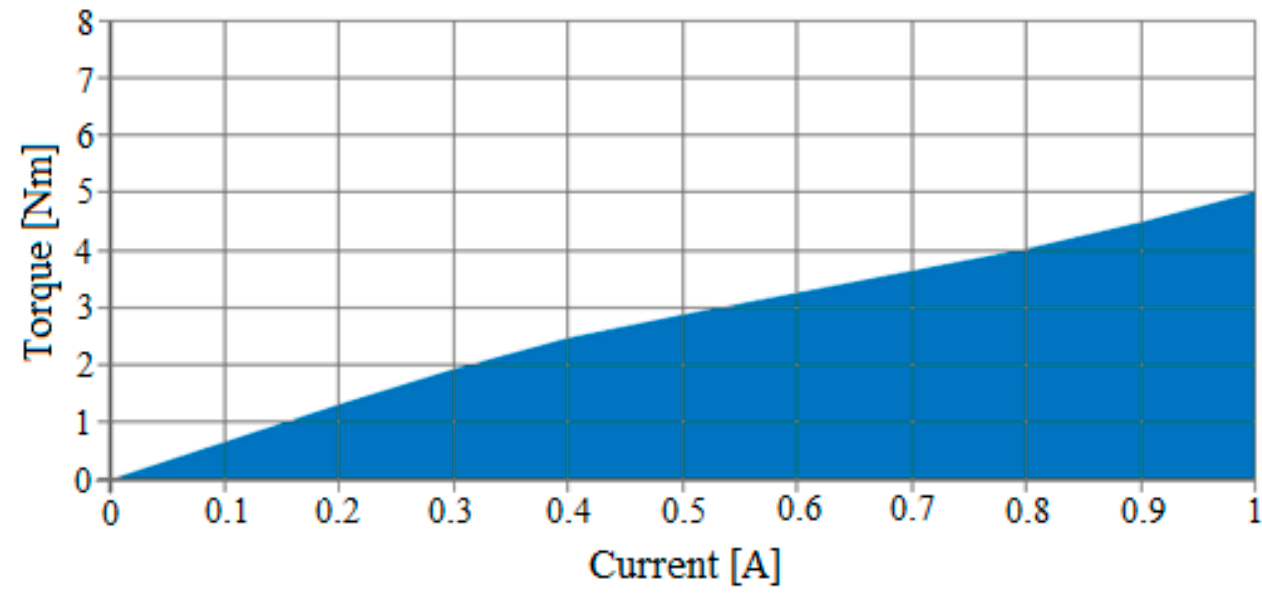
Figure 8. Current-torque characteristic of the powder brake .